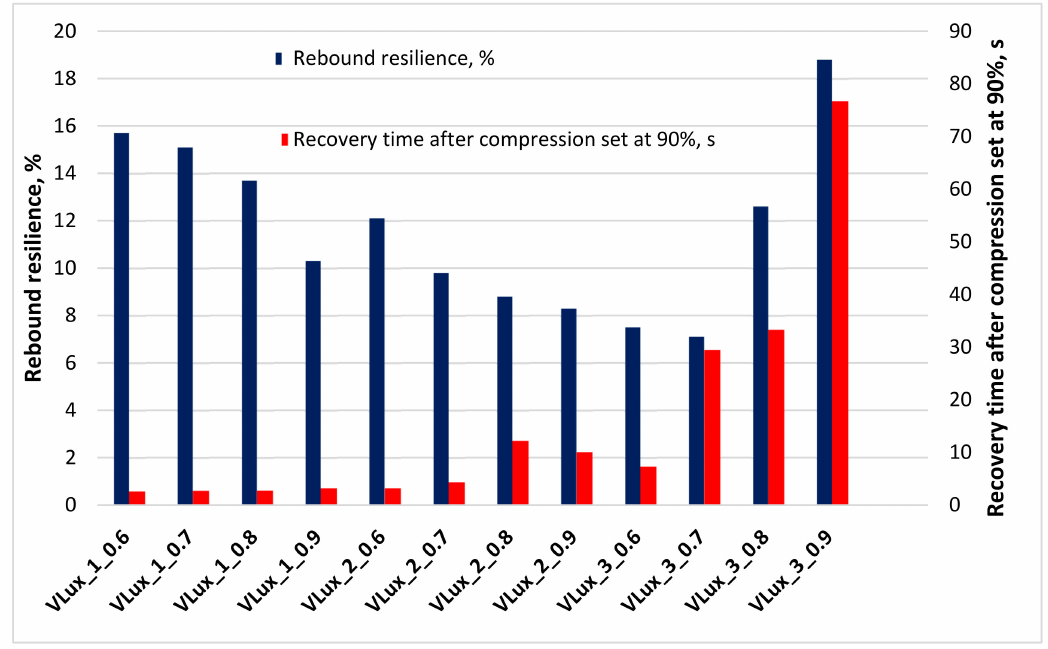
Figure 15. Recovery time and rebound resilience of analyzed